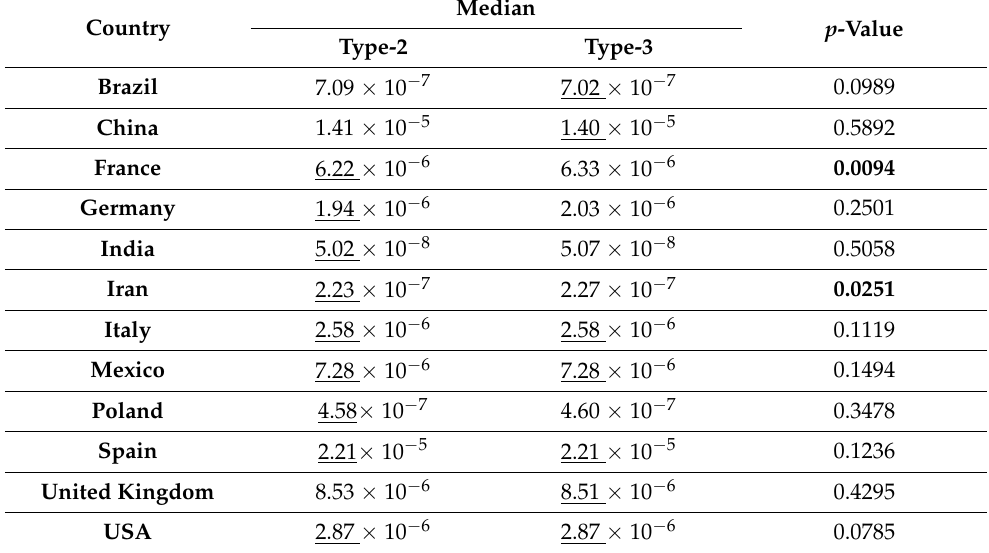
Table 16. Mann–Whitney results (first data period, testing prediction).